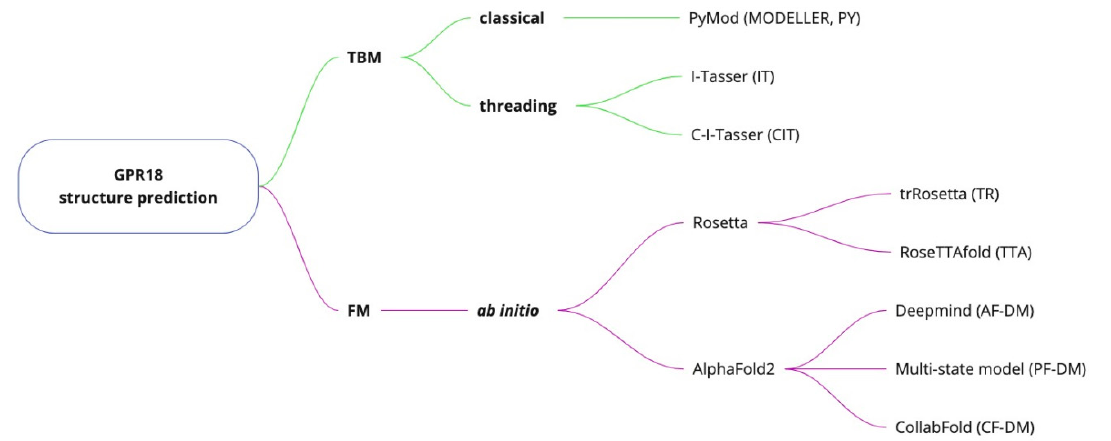
Figure 14. GPR18 structure prediction methods and software used in this study. Shortcuts in brackets denote particular model names prefixes.